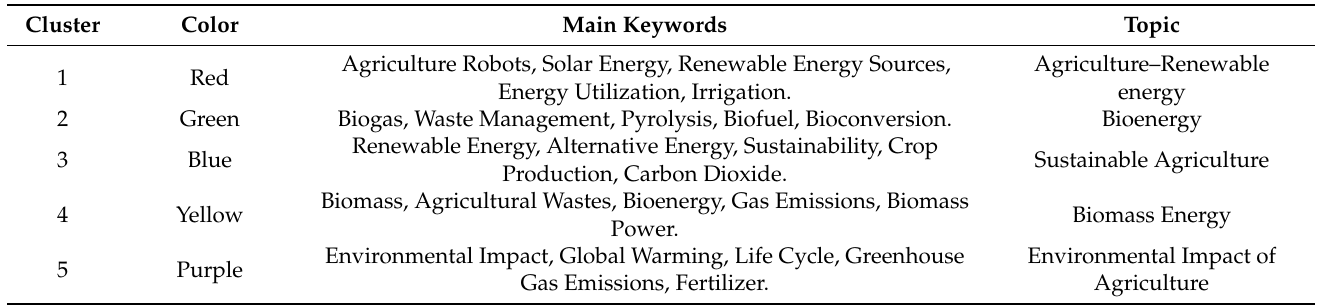
Table 6. Main clusters obtained in co-occurrence analysis for the topic of renewable energies in